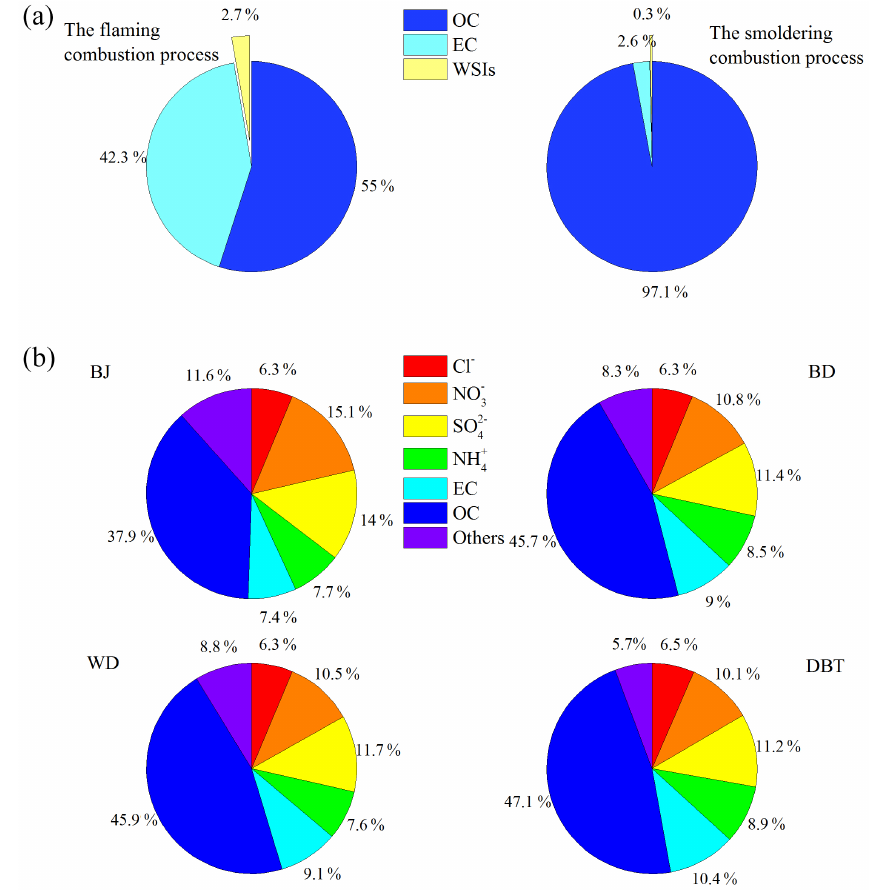
Figure 7. The mass proportions of OC, EC and WSIs from residential coal combustion under the flaming and smoldering combustion processes (a) , and the average mass proportions of the typical species in PM 2 . 5 at the four sampling sites during the sampling period in the winter of 2015 (b)